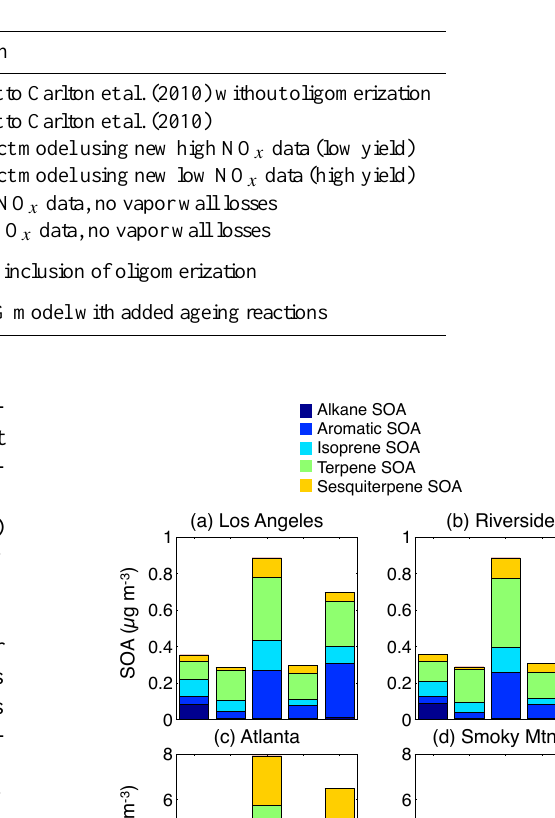
Figure 1: 14-day averaged SOA concentrations at Los Angeles (a), Riverside (b), Atlanta (c) and Smoky Mountains (d) for the Base, BaseM, and SOM simulations resolved by the precursor/ pathway.